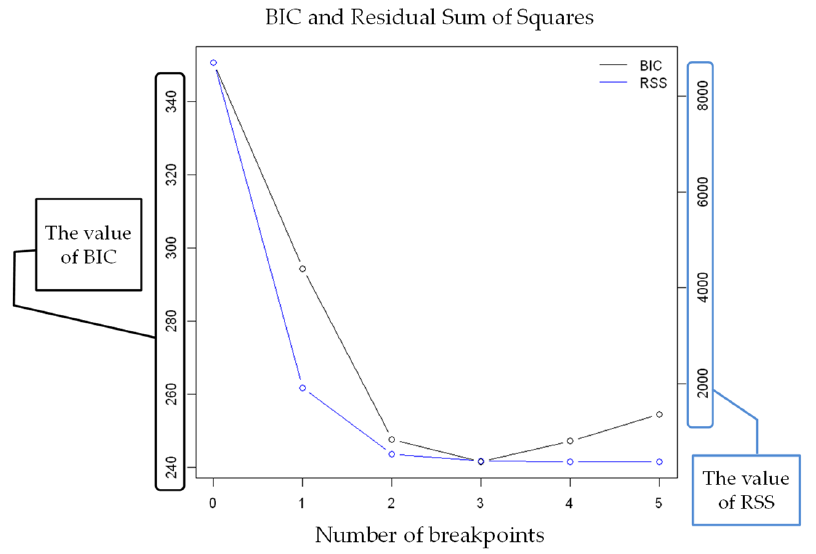
Figure 6. Number of breakpoints (VE).